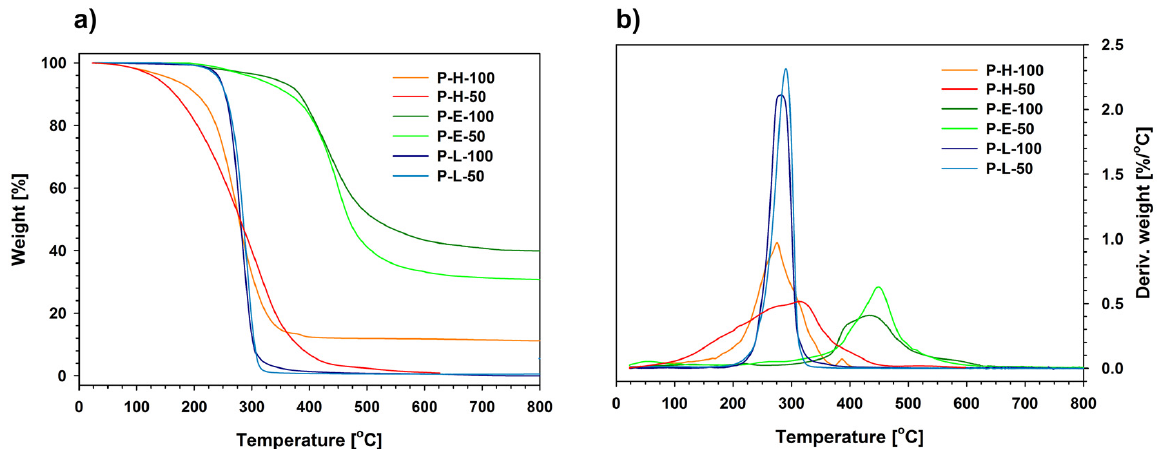
Figure 5 . Comparison of TGA curves (N 2 , 10 ° C/min) of the studied polysiloxanes ( a ) sample weight decrease and ( b ) derivative of the weight change. Table 1. Thermal degradation characteristics of the functionalized polysiloxanes and their precur- sors.